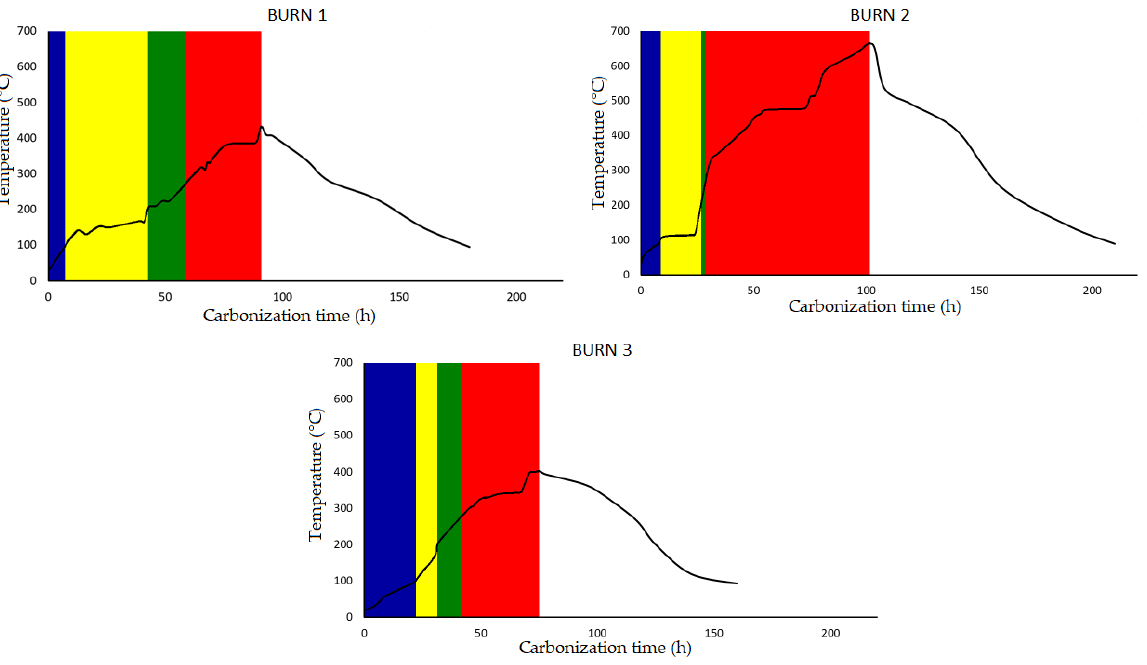
Figure 8. Heating ramps during carbonization in three burnings of Argentine half-orange kilns. Blue color = phase 1, yellow color = phase 2, green color = phase 3, red color = phase 4, white color = phase 5. This carbonization process includes the following species: White oak and Red oak. Table 5. Burning time and heating ramps on each phase during carbonization in an Argentine half-orange kiln.